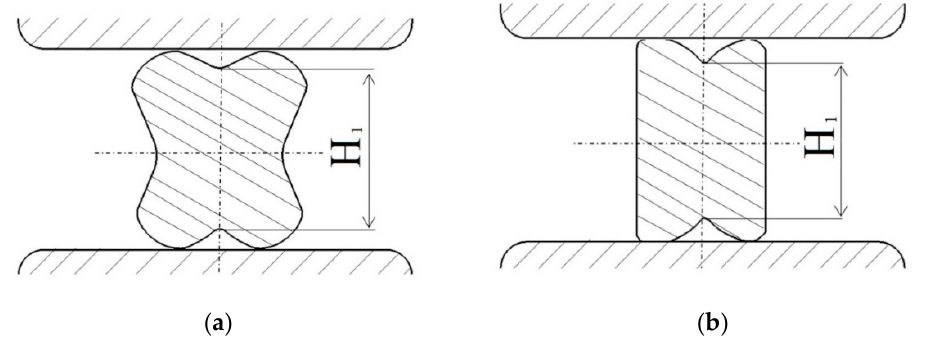
Figure 5. Order of forging the workpiece with a concave cross-section with flat anvils ( a ) after the first pass, ( b ) after the second pass.